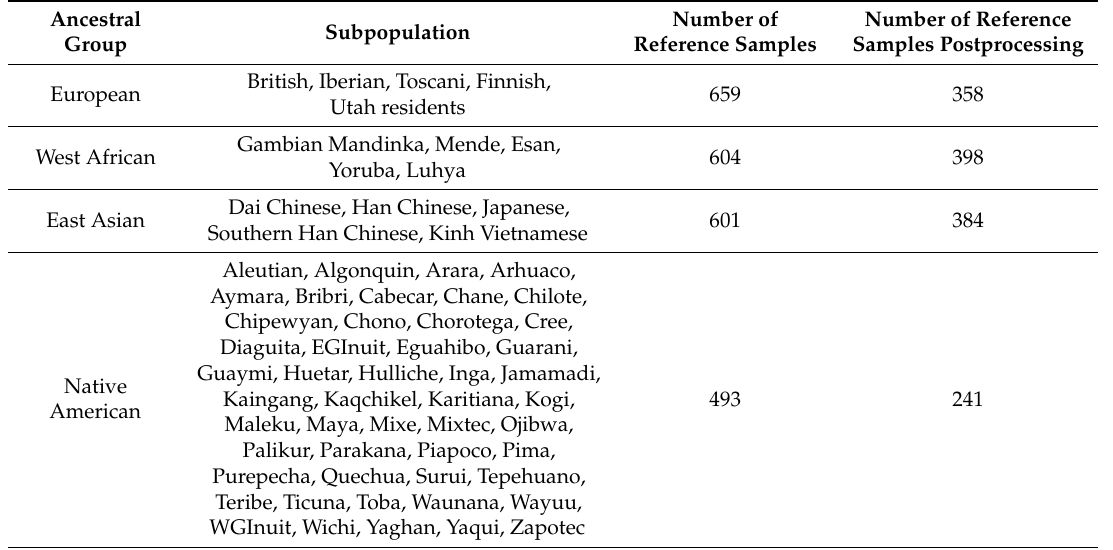
Table 2. Summary of control genomes used in genetic ancestry